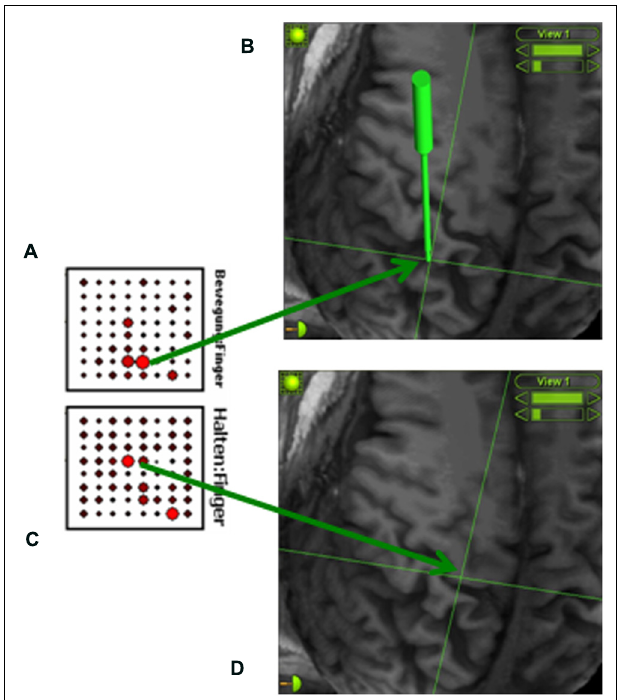
FIGURE 2 | Online detection of cortical areas related to phantom hand movement using the SIGFRIED module within the BCI2000 framework (Schalk etal., 2008a,b). This procedure creates a statistical model of baseline brain activity and detects significant deviations from this baseline in real-time during the task. During each trial, z-scores between the distributions of negative log likelihood values for the task and interleaved rest periods are calculated, resulting in one continuously updated z-score for each electrode location and task.These z-scores are shown on a topographical display for each task ( A : finger extension; C : holding finger extension) as a circle at each electrode location whose diameter is proportional to the z-scores at that location, thus enabling real-time assessment of cortical changes (Schalk etal., 2008a,b). An image-guidance approach with a navigated pointer (green) allows for relating the electrodes with the strongest activity to the underlying cortical anatomy ( B : somatosensory cortex; D : primary motor cortex) without exposing the brain surface.